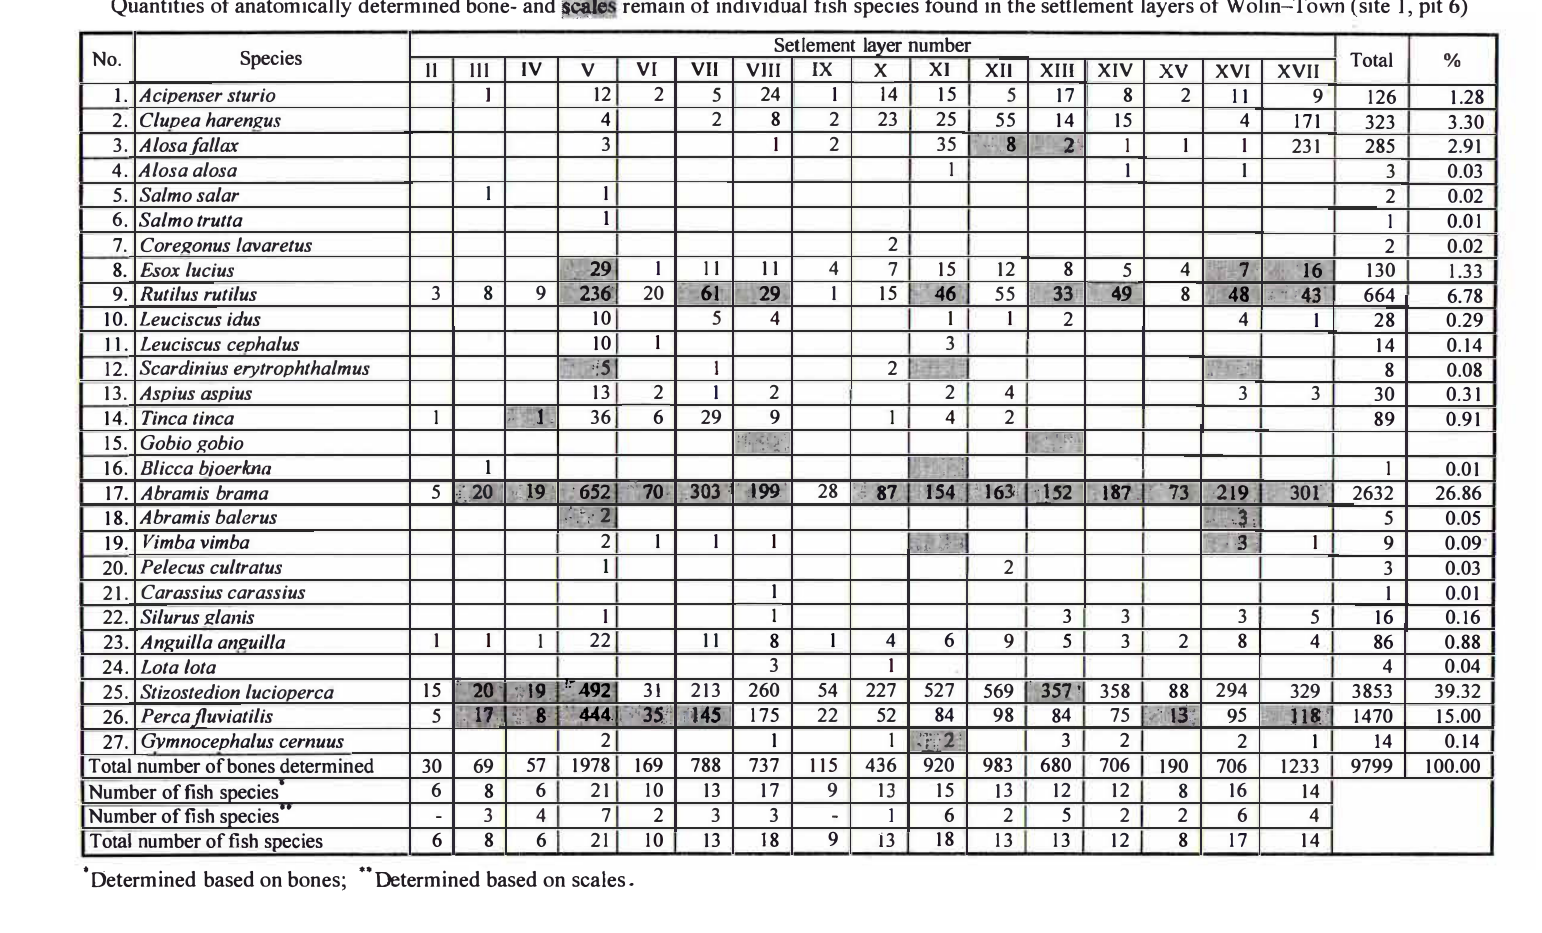
Quantities of anatomically determined bone-and iCl!Je remain of individual fish species found in the settlement layers of Wolin-Town (site I, pit 6)